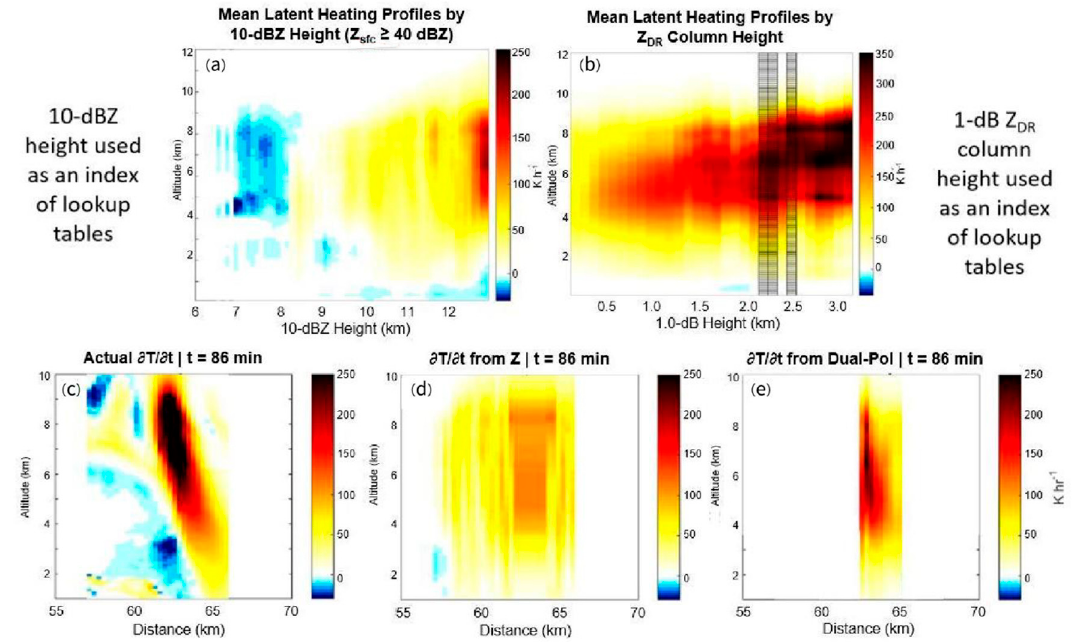
Figure 18. ( a ) Mean vertical profiles of warming rates as functions of the height of the Z = 10 dBZ level. ( b ) Mean vertical profiles of warming rates as functions of the height of the Z DR = 1 dB level. ( c ) Vertical cross-section of the warming rate (dT / dt) obtained from the HUCM simulation of the storm 86 min after the beginning of its life cycle. ( d ) Vertical cross-section of the warming rate (dT / dt) if a height of the Z = 10 dBZ level is used as a lookup table index. ( e ) Vertical cross-section of the warming rate (dT / dt) if a height of the Z DR = 1 dB level is used as a lookup table index. Hatched indices indicate profiles that were linearly interpolated due to a lack of data. All simulations were performed using HUCM and the polarimetric radar forward operator from Ryzhkov et al.